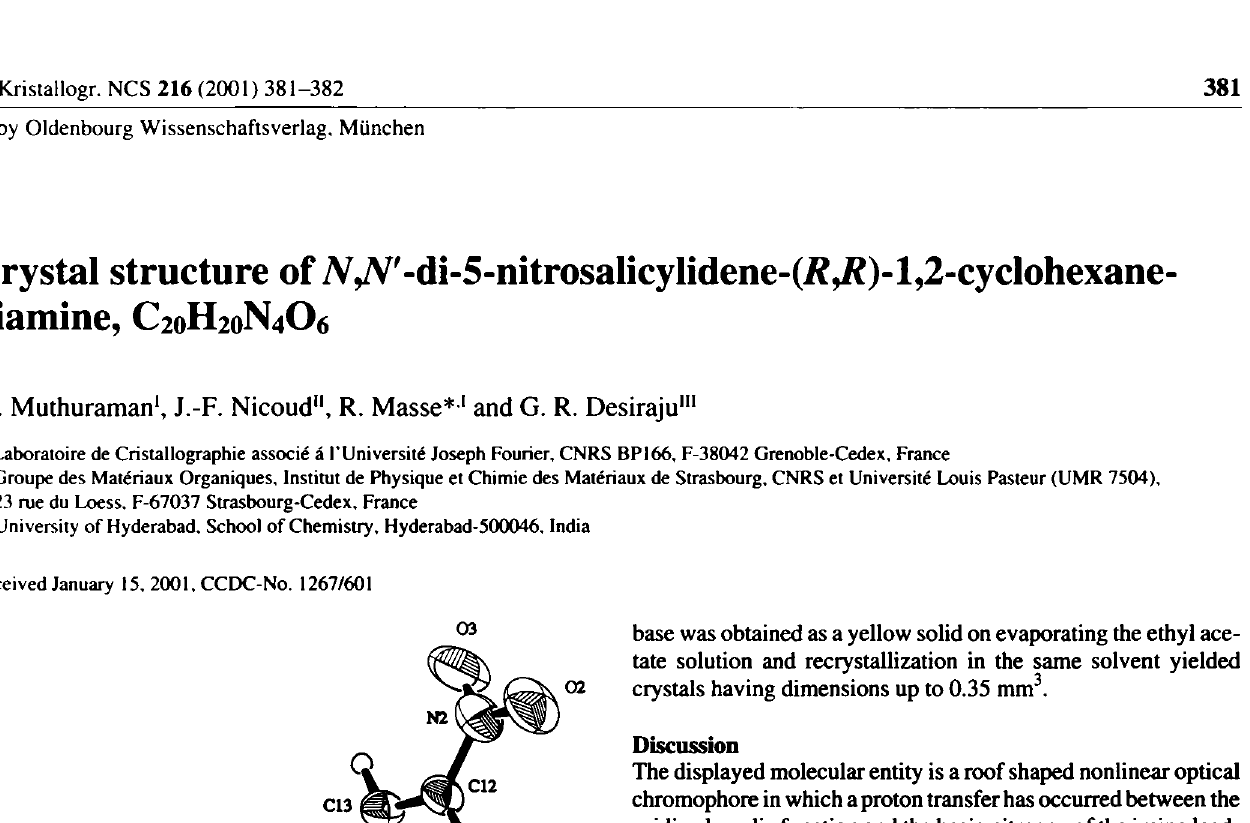
Table 1. Data collection and